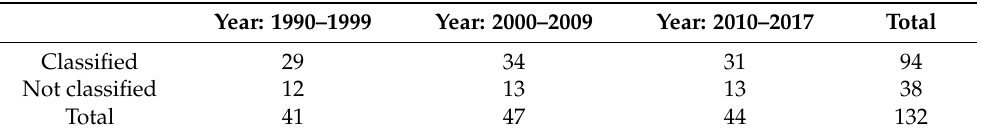
Table 7. STAX-SA classification according to publication